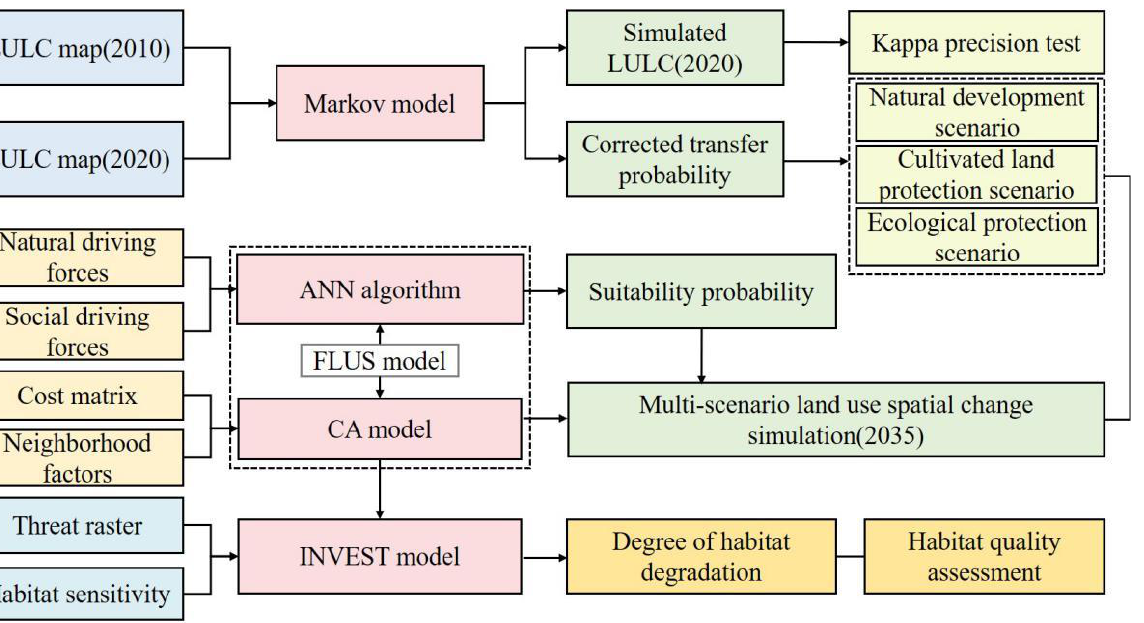
Figure 1. Research framework.